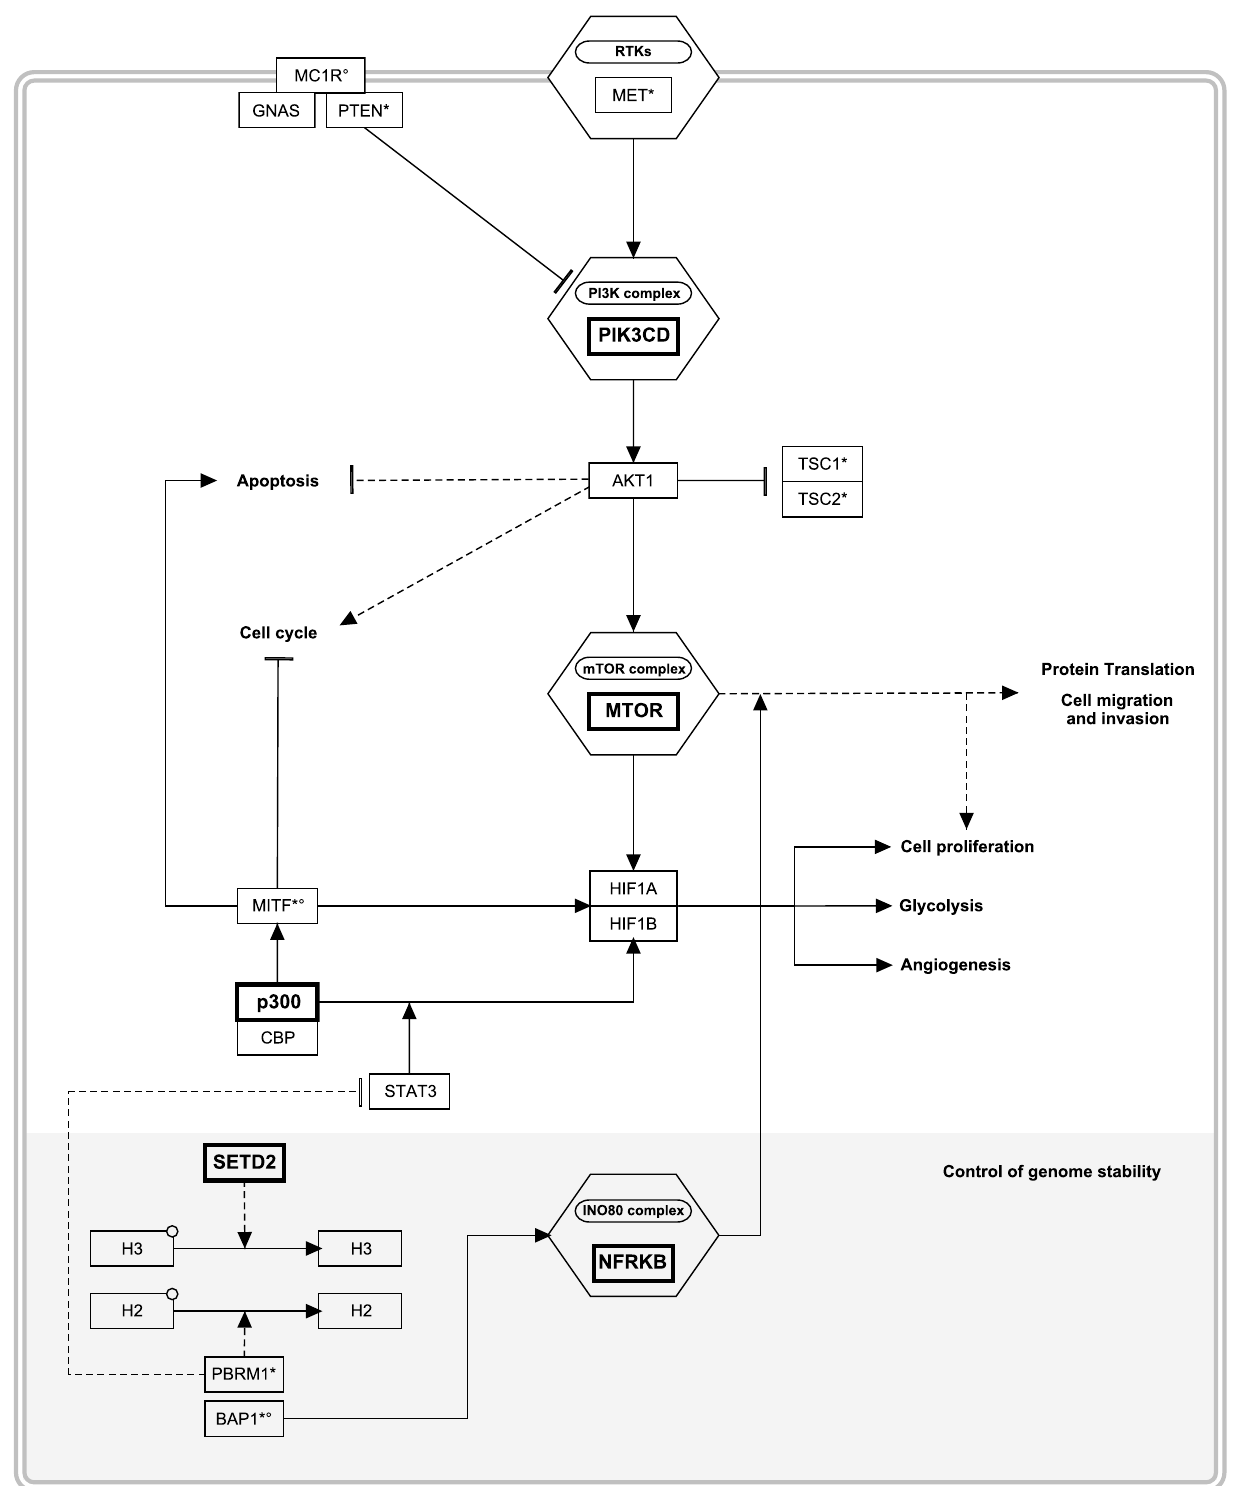
Figure 2. Overview of the PI3K/Akt/mTOR signaling pathway. Newly identified candidate genes are highlighted in bold. ◦ Established CMM-predisposing genes. * Established RCC-predisposing genes. RTKs: Receptor tyrosine kinases; H2, H3: histones. This figure was built from the “Pathways in clear cell renal cell carcinoma” pathway [68] hosted on WikiPathways